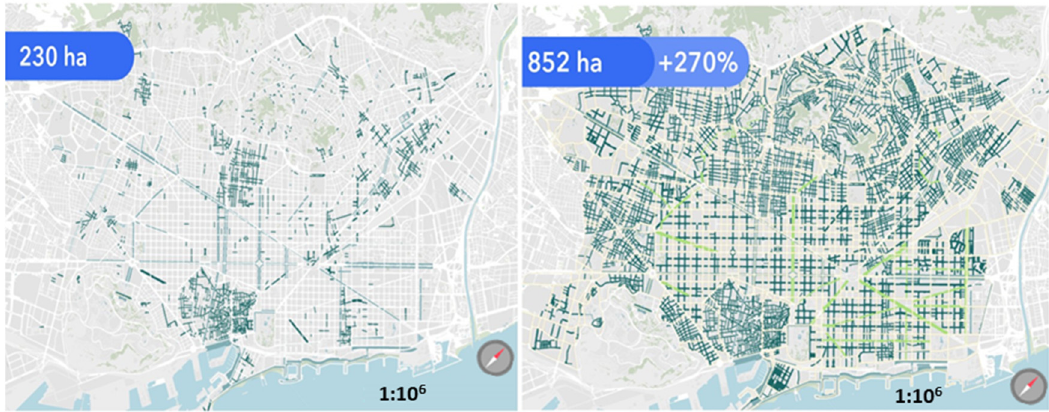
Figure 7. Pedestrian space in Barcelona before and after Superblocks. Source: Reproduced from [15].